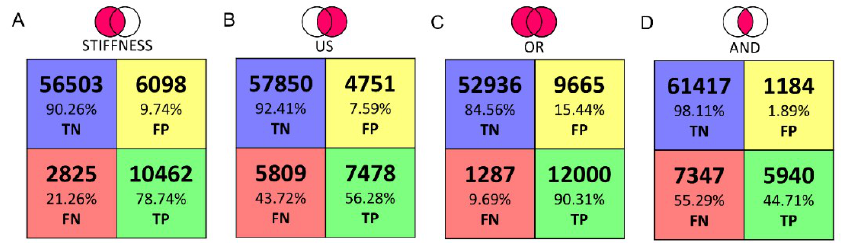
Figure 8. Classification (TP–TN–FP–FN) for all the points of the indentation matrix following the AND ( A ) and OR ( B ) logics of stiffness‐ and ultrasound‐based classifications shown in Figure 7.